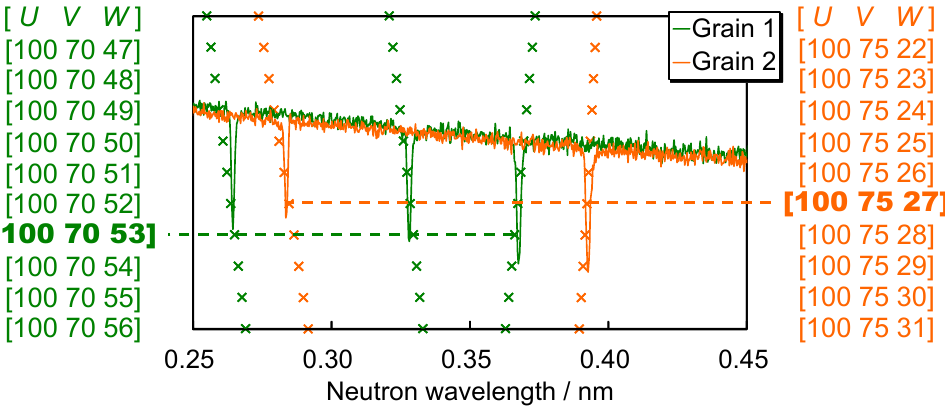
Figure 2. Scheme of the database matching method. (Note that exampled neutron transmission spectra were measured by the experiment presented in Reference [28].) Even if a few grains are stacked along the neutron transmission path, the unique crystal-lattice direction [ UVW ] of each grain, parallel to the neutron transmission direction, are simultaneously identified by this method. This figure schematically indicates that [ UVW ] of one of stacked grains (Grain 1) is [100 70 53] and [ UVW ] of the other of stacked grains (Grain 2) is [100 75 27].